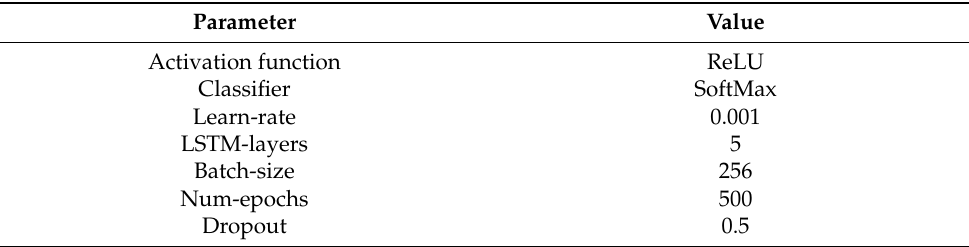
Table 4. Parameters of LSTM